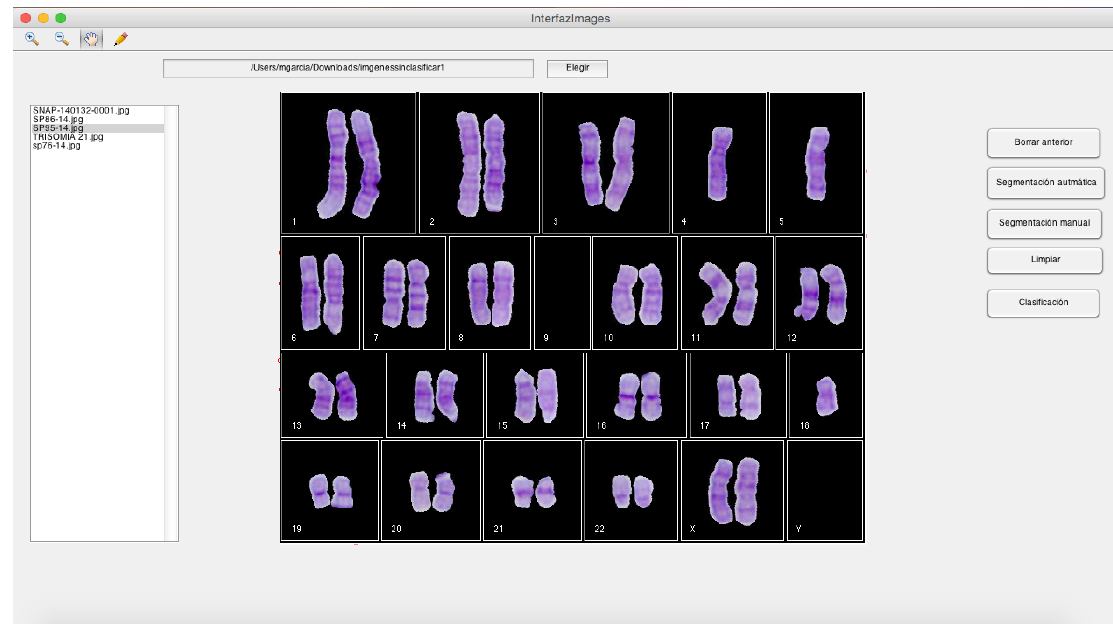
Figure 18. Screenshot of the proposed chromosome segmentation application, where a preliminary karyogram is